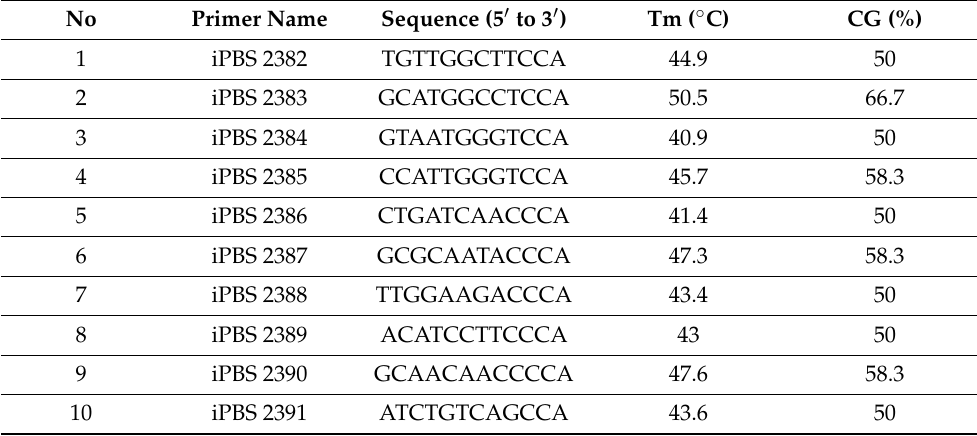
Table 3. Reactive primers used in iPBS PCR and their annealing (Ta)